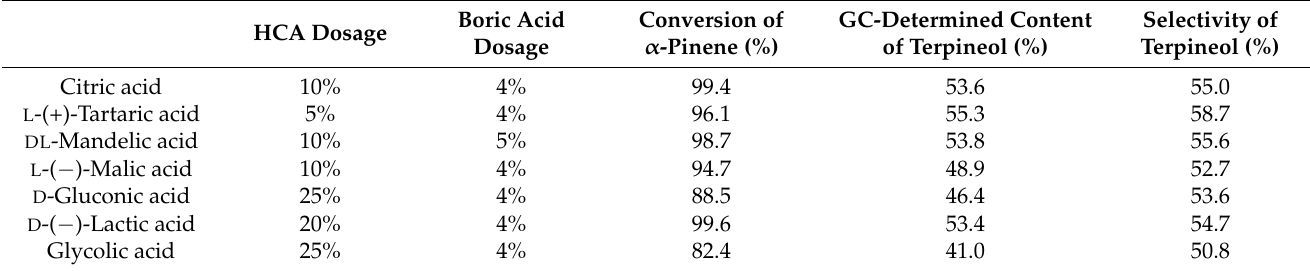
Table 1. Optimal dosages of boric acid and HCAs of each catalyst group a